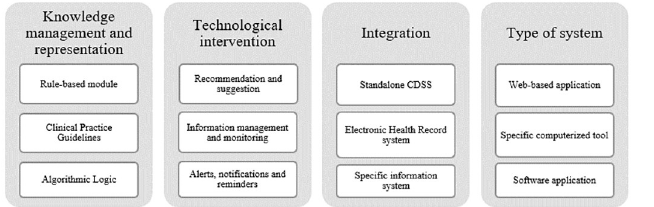
Fig 3. Characterization of general trends obtained through the